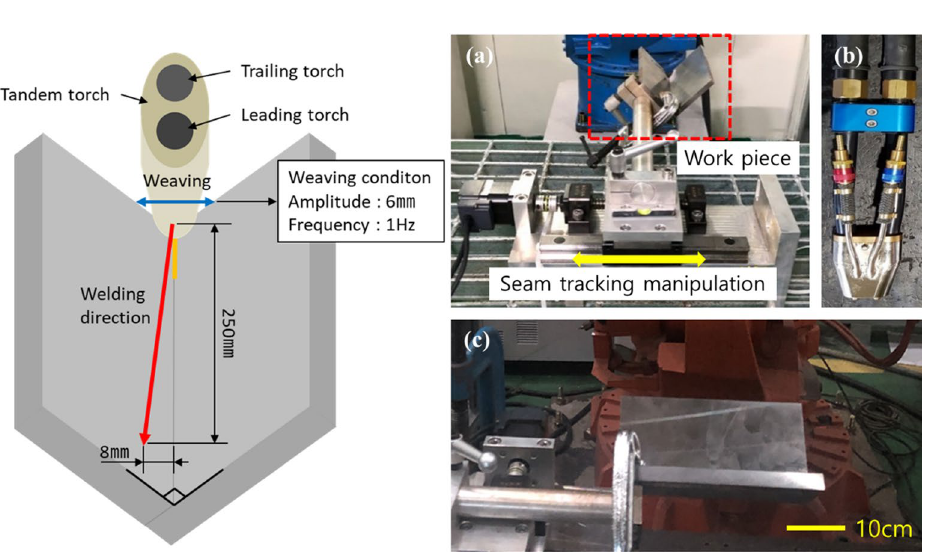
Figure 8. Welding method and device configuration for seam tracking. ( a ) Experimental schematic for welding line trace test, ( b ) seam tracking device configuration, ( c ) tandem torch, and ( d ) base